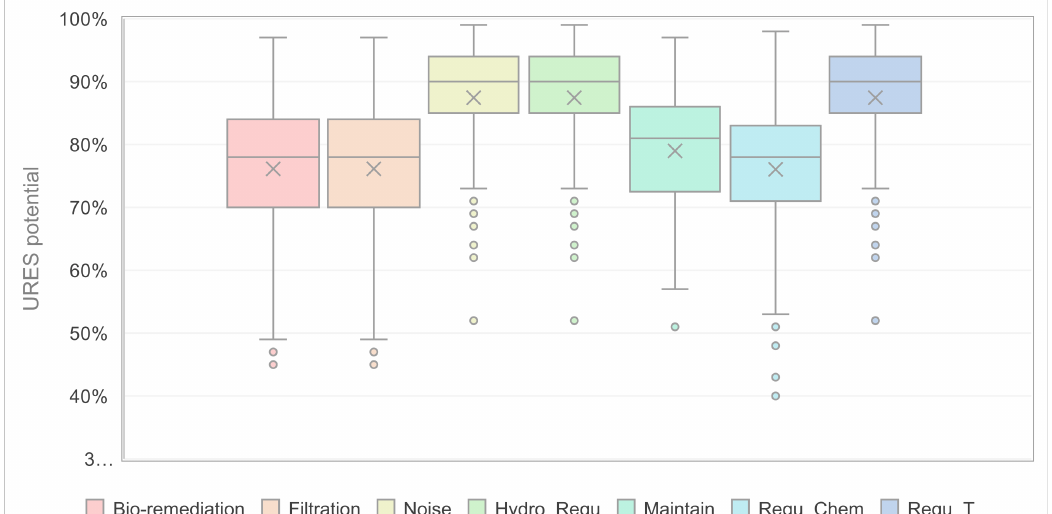
Figure 6. Box plots of Urban River Ecosystem Service potential of the all sections of the Pochote River: ‘Bio-remediation’ stands for ‘Bio-remediation by micro-organisms, algae, plants, and animals’; ‘Filtration’ means ‘Filtration / sequestration / storage / accumulation by micro-organisms, algae, plants, and animals’; ‘Noise’ represents ‘Noise attenuation’; ‘Hydro_Regu’ short for ‘Hydrological cycle and water flow regulation’; ‘Maintain’ refers to ‘Maintaining nursery populations and habitats’; ‘Regu_Chem’ signifies ‘Regulation of the chemical condition of freshwaters by living processes’; ‘Regu_T’ equals ‘Regulation of temperature and humidity, including ventilation and